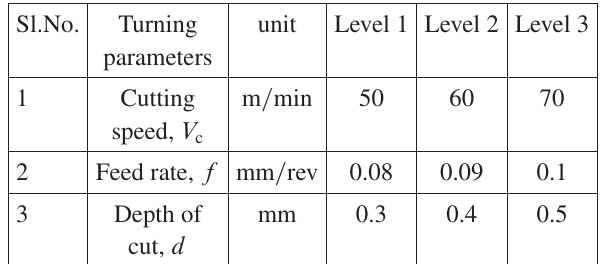
Table 1. Turning parameters and their levels.